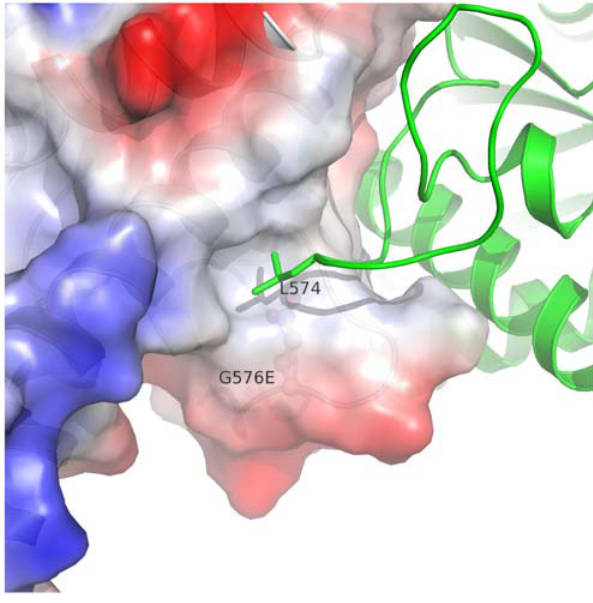
Figure 7. Dimer interface around residue G576. Surface charge of one molecule is shown around residue G576 (red for negatively charged surface, blue for positively charged surface). Side chain of L574 from another molecule is buried into the hydrophobic patch around G576. The side chain of the glycine residue is mutated to that of a glutamic acid residue and shown in ball-stick mode.